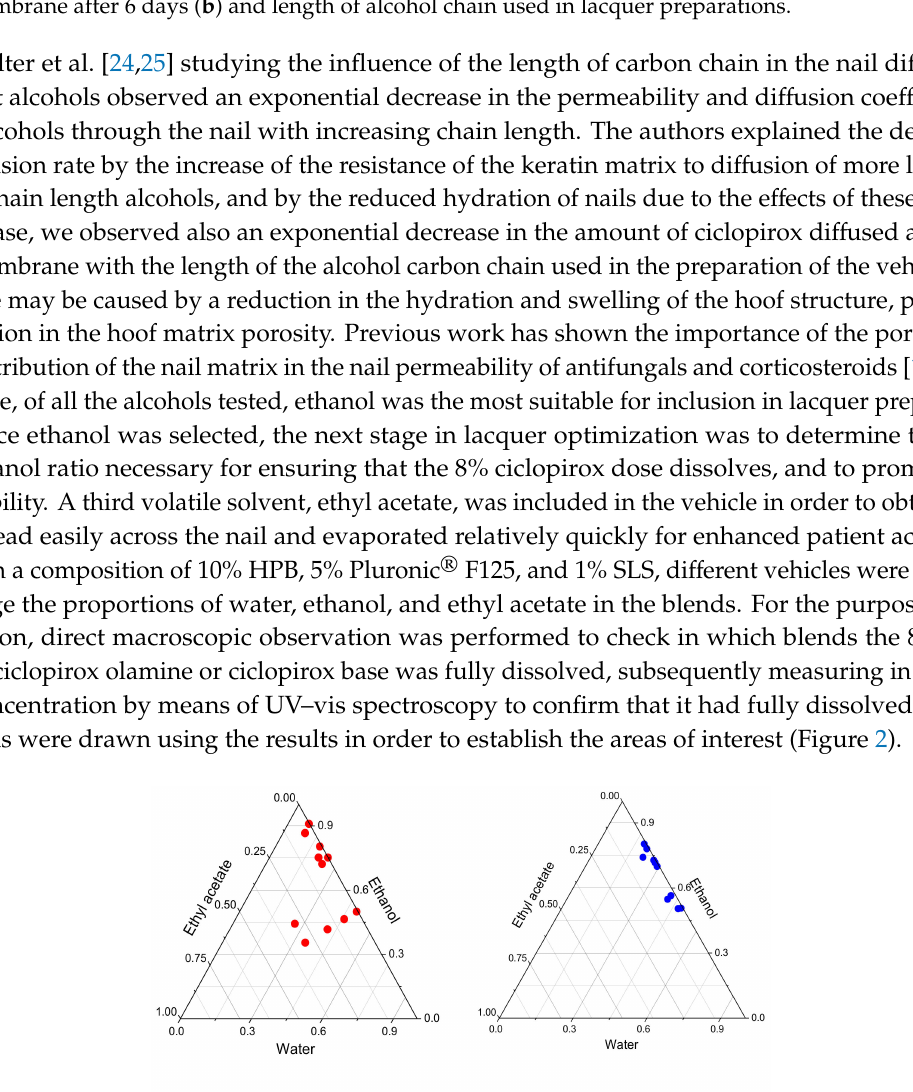
Figure 1. Di ff usion kinetics ( a ) and the relationship between amount of ciclopirox di ff used across hoof membrane after 6 days ( b ) and length of alcohol chain used in lacquer preparations.